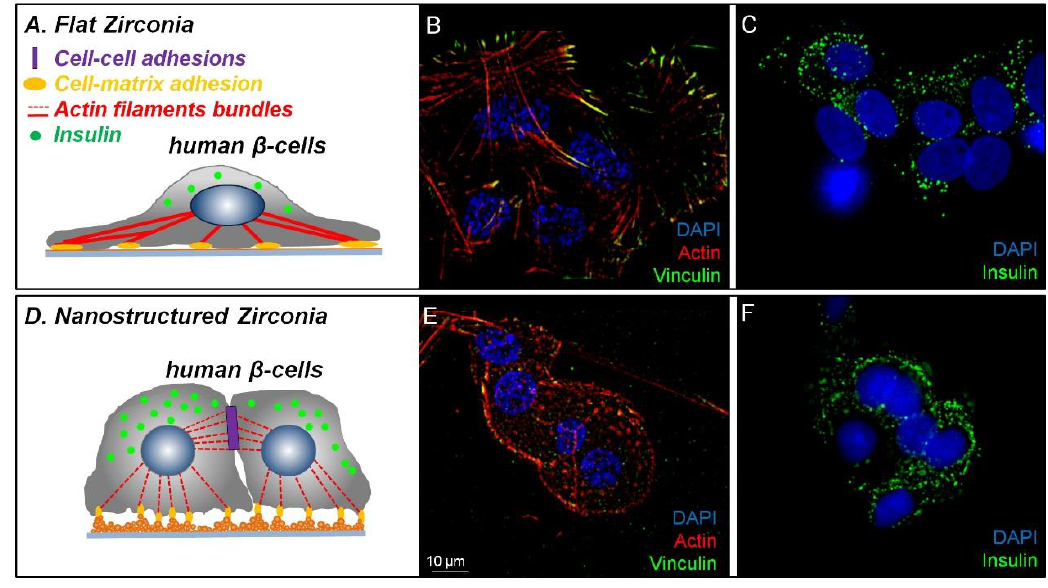
Figure 3. β -cells sense the ECM-mimicking nanotopography and activate a Figure 3. β-cells sense the ECM-mimicking nanotopography and activate a mechanotransduction- mechanotransduction-dependent program, which promotes their di ff erentiation. Human dependent program, which promotes their differentiation. Human islets of Langerhans grown on flat ( A – islets of Langerhans grown on flat ( A – C ) or nanostructured ( D – F ) zirconia for 20 days were stained C ) or nanostructured ( D – F ) zirconia for 20 days were stained with DAPI (4′,6-diamidino-2-phenylindole) with DAPI (4 (cid:48) ,6-diamidino-2-phenylindole) (blue) and for actin (red), and vinculin (green) to visualize (blue) and for actin (red), and vinculin (green) to visualize the modulation of the mechanotransduction the modulation of the mechanotransduction pathway in ( B , E ); or with DAPI (blue) and insulin (green) pathway in ( B , E ); or with DAPI (blue) and insulin (green) to ascertain the β-cell phenotype ( C , F ). ( A – C ) to ascertain the β -cell phenotype ( C , F ). ( A – C ) Cell–matrix interactions predominate in islet cells grown Cell–matrix interactions predominate in islet cells grown on flat substrates. β-cells present few insulin on flat substrates. β -cells present few insulin granules and are scattered on this substrate. ( D – F ) Cells grown on the nanotopographical substrates instead adopt a round shape, which favors the establishment of cell–cell contacts and the organization in islet-like clusters where β -cells are full of insulin granules. Note also the di ff erent nuclear shapes and sizes of the cells grown on flat or nanostructured substrates